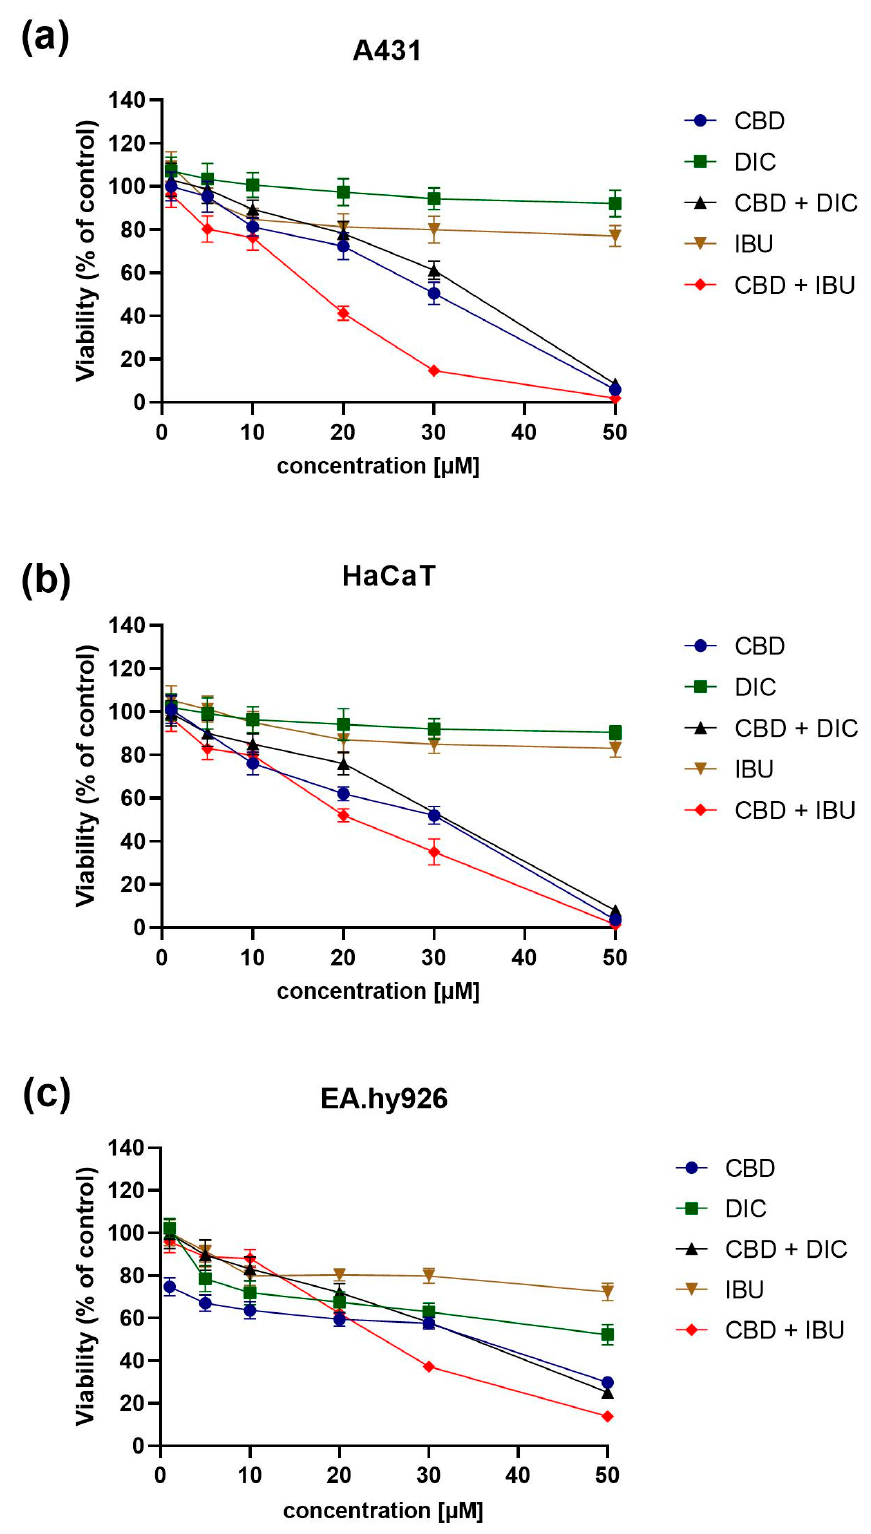
Figure 1. The cytotoxicity evaluation of CBD, DIC, the combination of both CBD and DIC, IBU and the combination of CBD and IBU on A431 ( a ), HaCaT ( b ) and ( c ) EA.hy926 cells. Control cells were treated with the vehicle. The values are shown as the mean ± SEM calculated from three independent experiments.